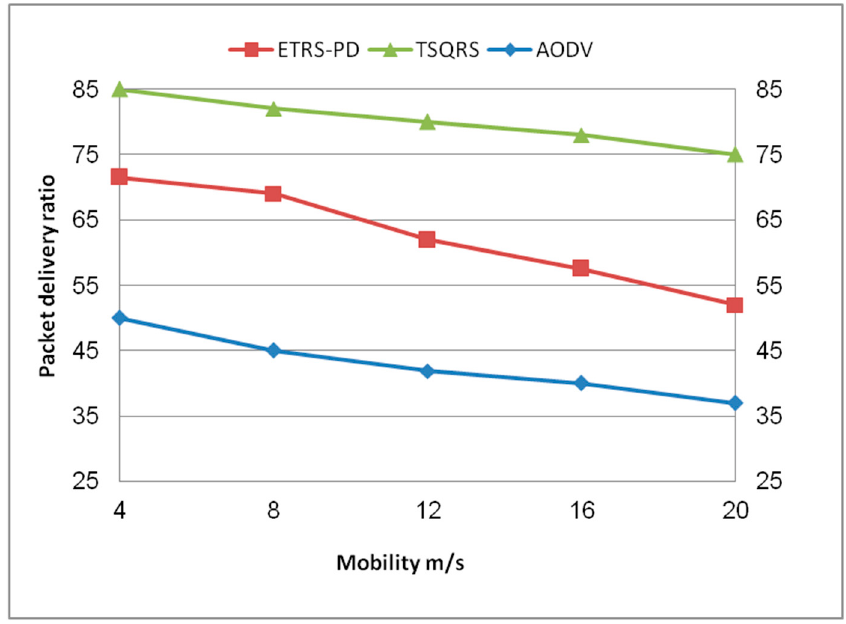
Figure 5. Packet delivery ratio (PDR) against mobility.